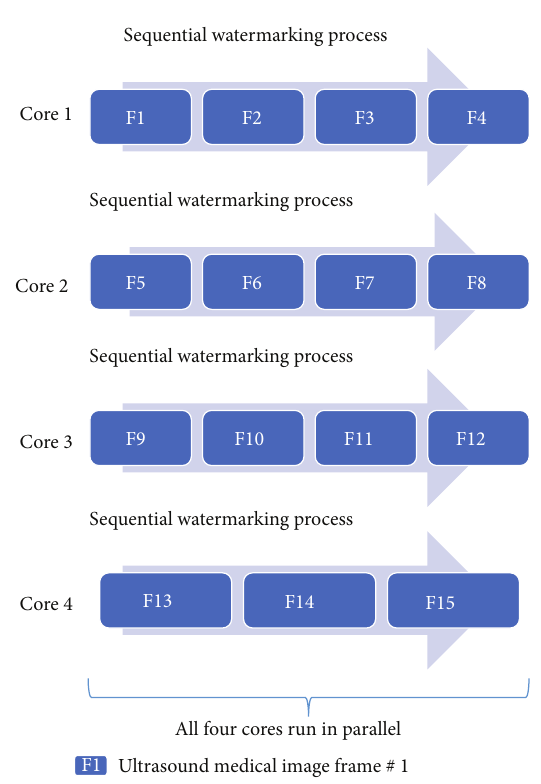
Figure 7: Inside look of parallel watermarking process that runs on 15 frames of ultrasound medical